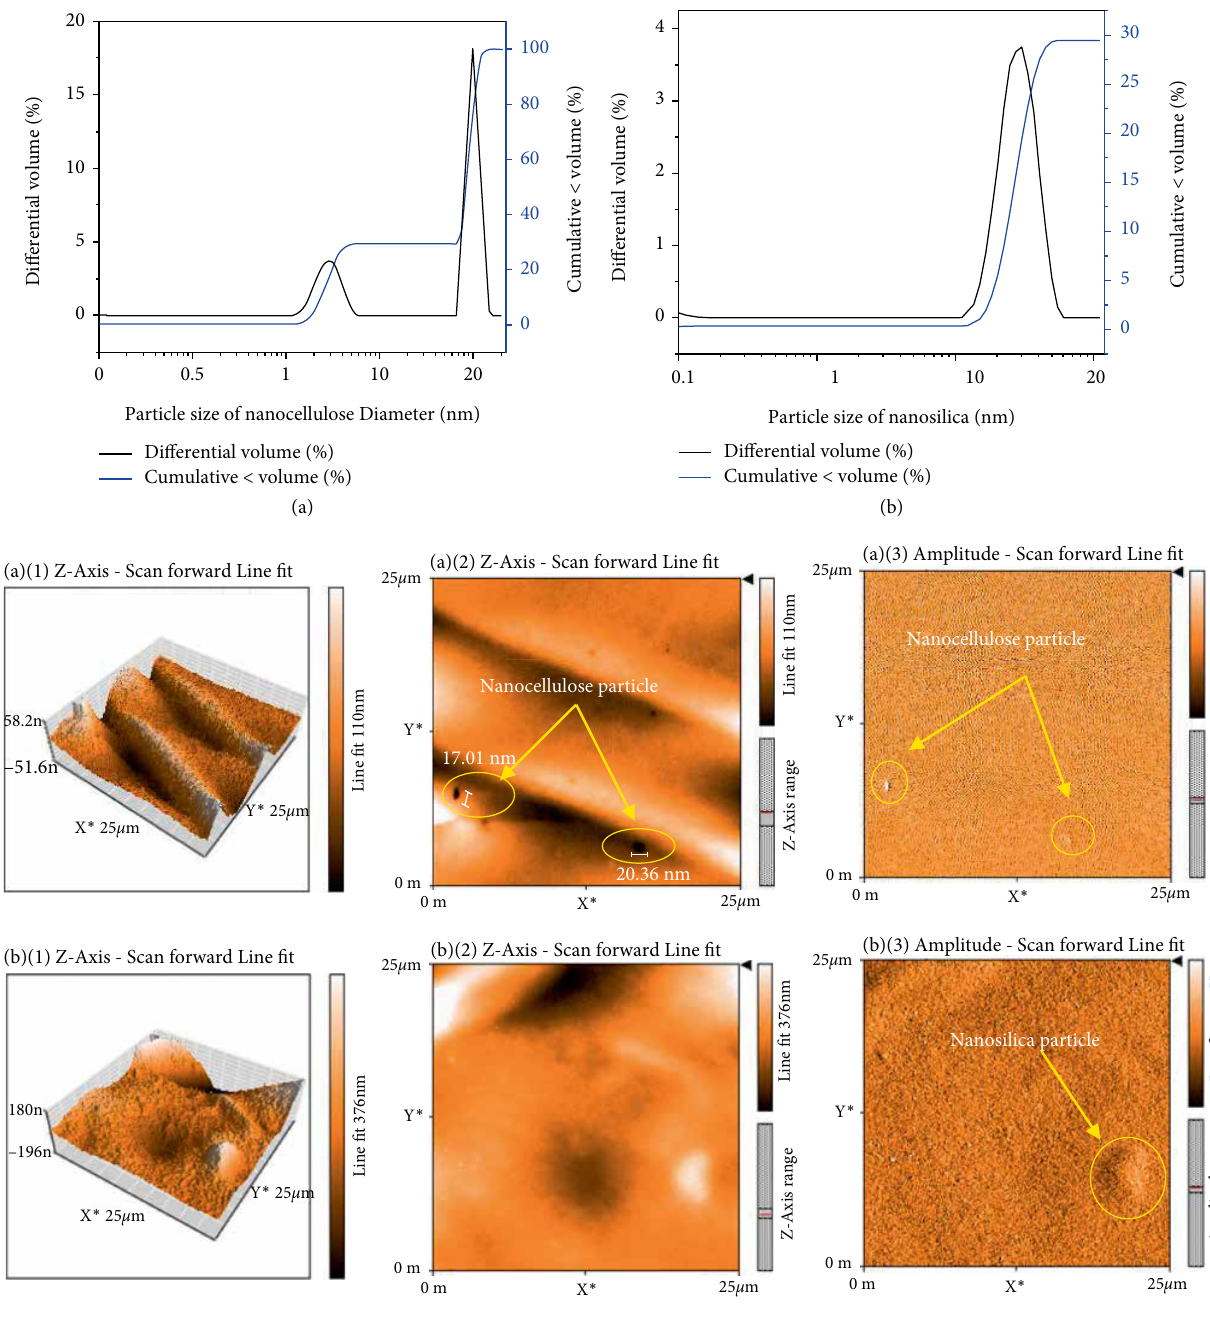
Figure 2: Particle size of nanofiller by dynamic light scattering and AFM images in topography of nanofiller, (a) nanocellulose, and (b) nanosilica; images in topography: (1) 3-D topography images of nanofiller, (2) phase 2-D of nanoparticles and (3) phase separate of